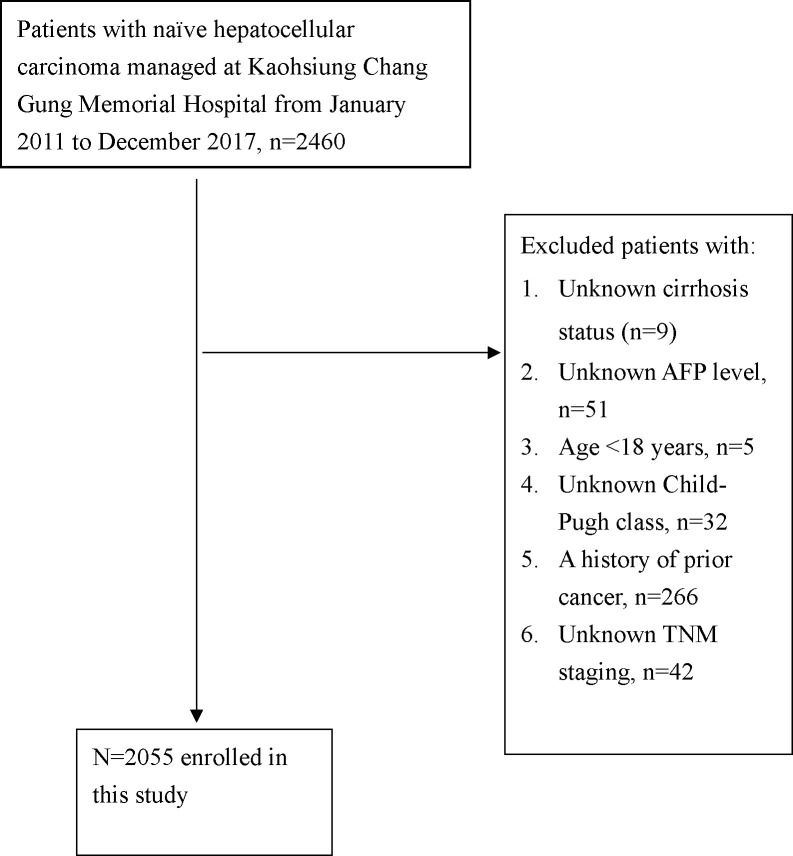
Flow chart of the patients’ enrollment.